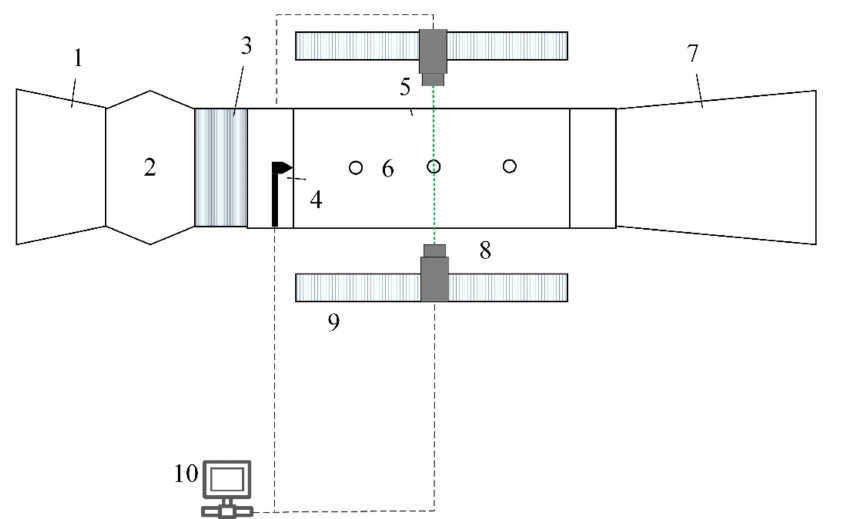
Figure 3. Schematic diagram of wind tunnel control system (1) draught fan, (2) wind tunnel, (3) ther- mostat heater, (4) air-blast spray nozzle, (5) visual segment, (6) observation hole, (7) diffused